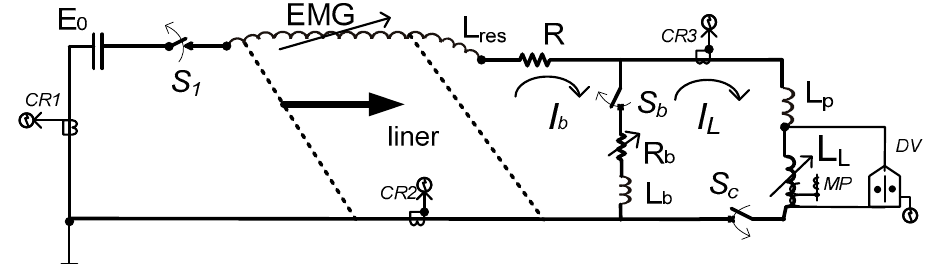
Figure 2. Equivalent electric circuit of load operation with EMG. Here, E 0 is the source of initial energy, R—the ohmic resistance in the EMG circuit including all of the ohmic losses of the magnetic flux, L res is the residual inductance of EMG at the time of load connection, L b is the inductance of the breaker circuit, S b —breaker key, S c —closer key, L L is the inductance of the load, L p is the parasitic inductance in the load circuit (inductance of the EMG energy output device), and R b is the active resistance of the breaker. CR1-CR3—Rogowski coils, DV—the voltage divider, and MP—magnetic probes.